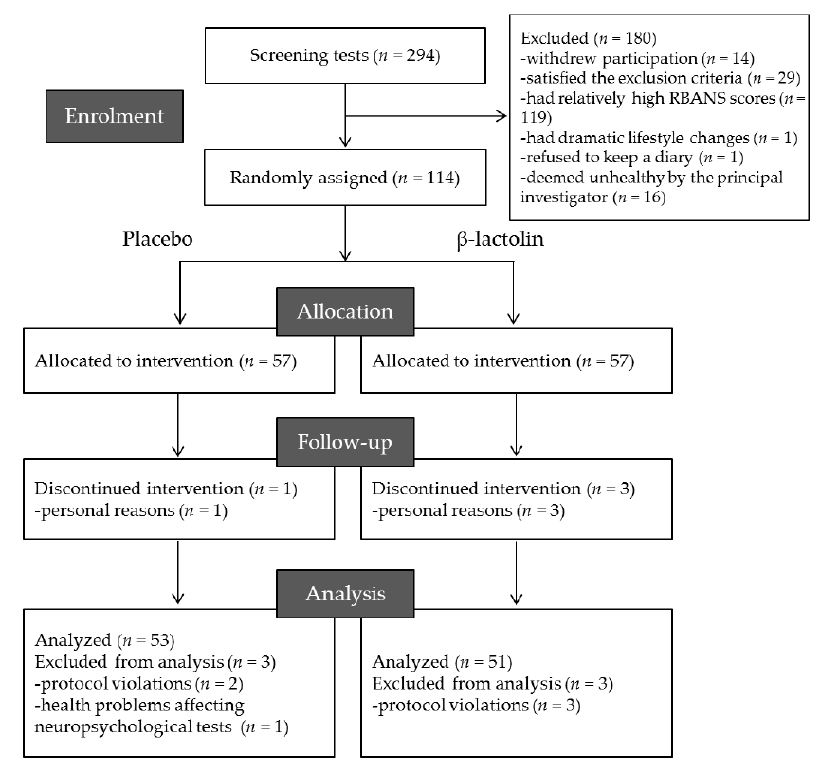
Figure 2. Consolidated standards of reporting trials diagram. Among the 294 participants screened, 114 were included. Participants were randomly allocated to placebo ( n = 57) and β -lactolin ( n = 57) groups. Four participants dropped out of the study, and 6 were excluded, leaving 53 and 51 participants in the placebo and β -lactolin groups for analysis, respectively. Table 1. Subject characteristics at baseline.